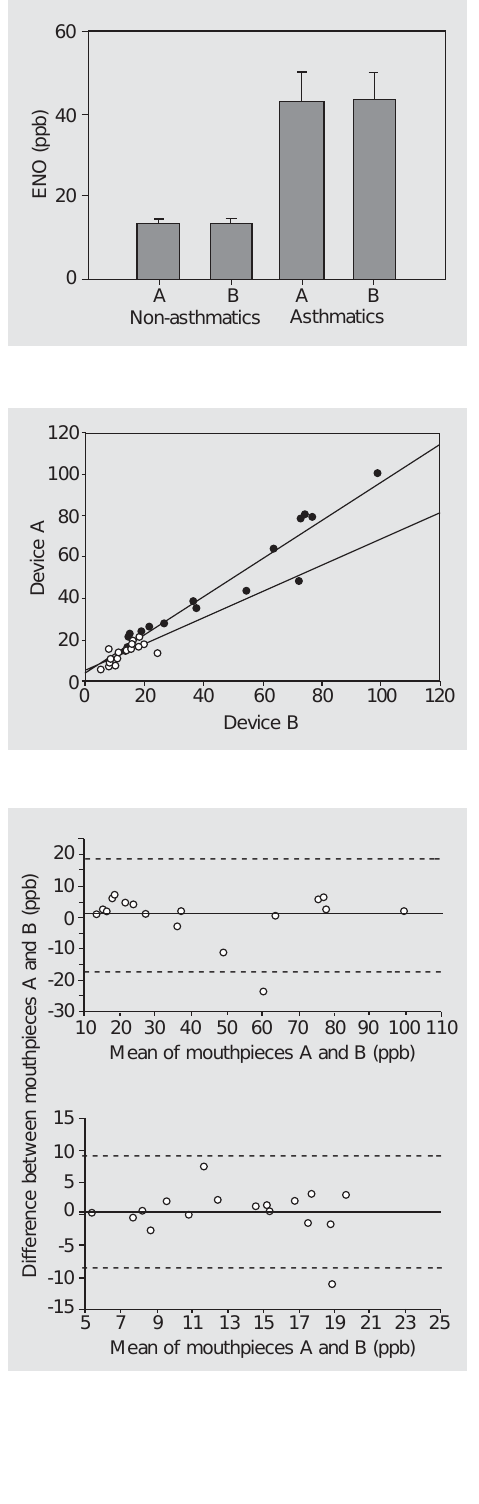
Figure 2. Exhaled nitric oxide (ENO) obtained with the differ- ent devices for asthmatic (N = 17) and non-asthmatic subjects (N = 17). There was no differ- ence in ENO between mouth- pieces A and B for asthmatic pa- tients or non-asthmatic subjects. However, there was a difference in ENO when asthmatic patients were compared with non-asth- matics using either device A (P<0.001) or device B